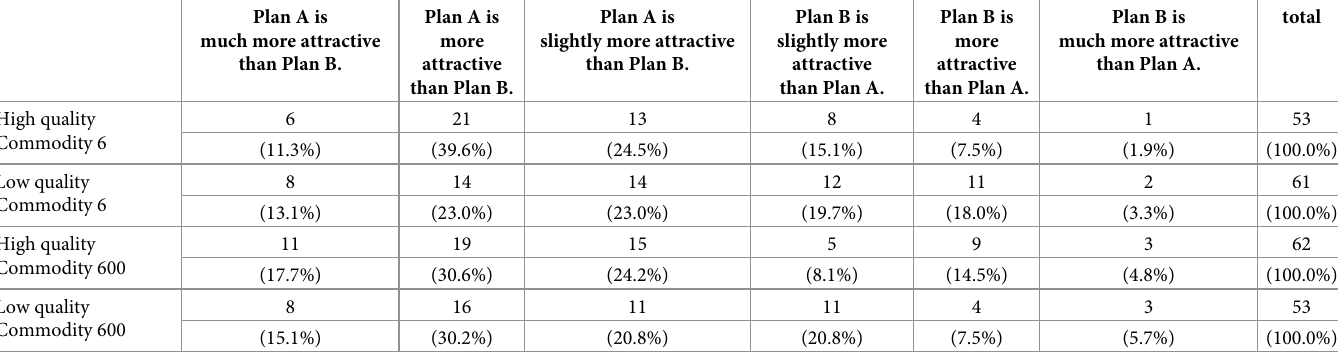
Table 8. Frequencies and percentages of choice in the commodity problem across 4 categories (positive frame). Plan A is much more attractive than Plan B.